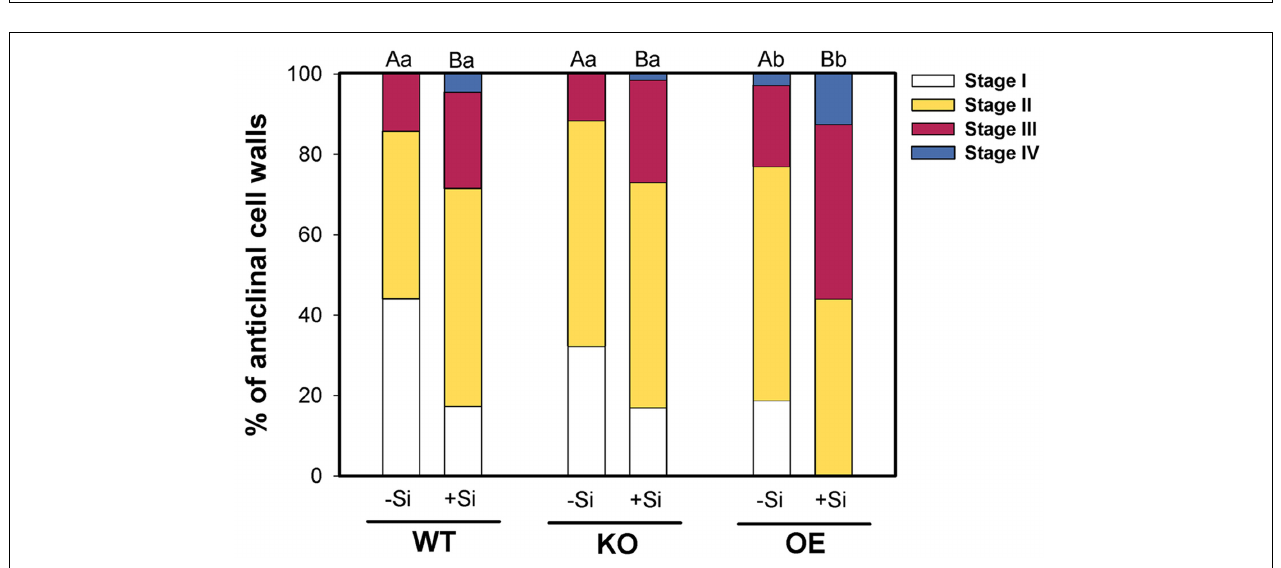
FIGURE 2 | Transcription of Casparian band (CB)-related genes in root zone 4–6 cm of WT, KO line 1B-14436 and OE line 3A-16329 . The OE plants were grown in nutrient solution with low (–Si, 3 mg Si L − 1 ) Si supply and KO grew in high (+Si, 30 mg L − 1 ) Si supply. The RQ of corresponding WT (–Si /OE; +Si/KO) = 1. Abbreviations of the genes are: 4CL, 4-coumarate ligase (LOC_Os01g67540); AT, glycerol-3-phosphate acyltransferase (LOC_Os05g20100); DGOAT, diacylglycerol O-acyltransferase (LOC_Os06g22080); LRR, leucine-rich repeat family protein (LOC_Os11g14050); PAL, phenylalanine-ammonia-lyase (LOC_Os02g41680); POD1 and 2, peroxidase (LOC_Os08g02110 and LOC_Os06g16350). A ∗ indicates significant differences between the WT and mutant plant at p < 0.01.